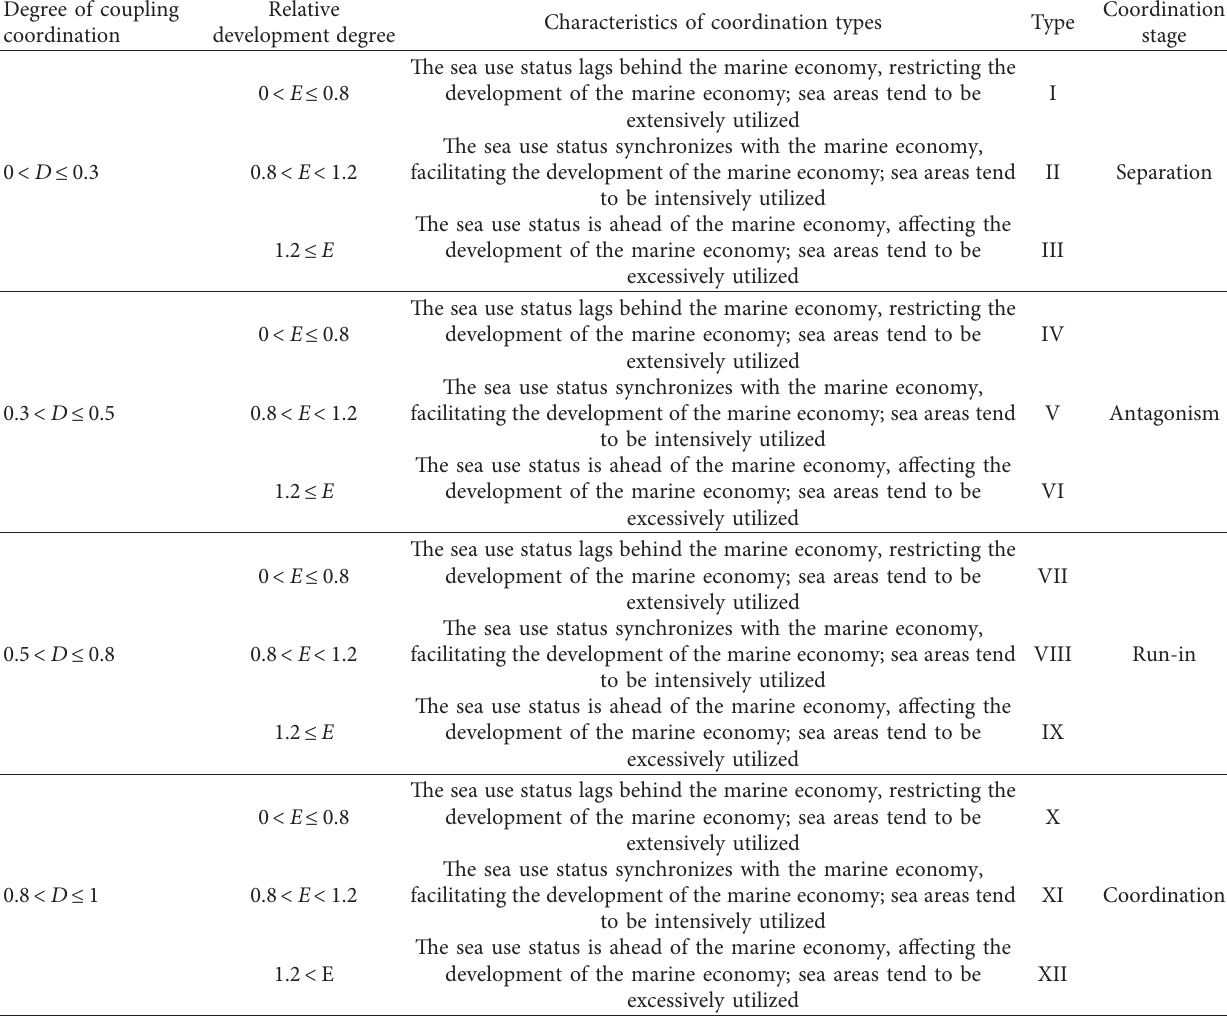
Table 4: Classification criteria and types of degree of coordination.